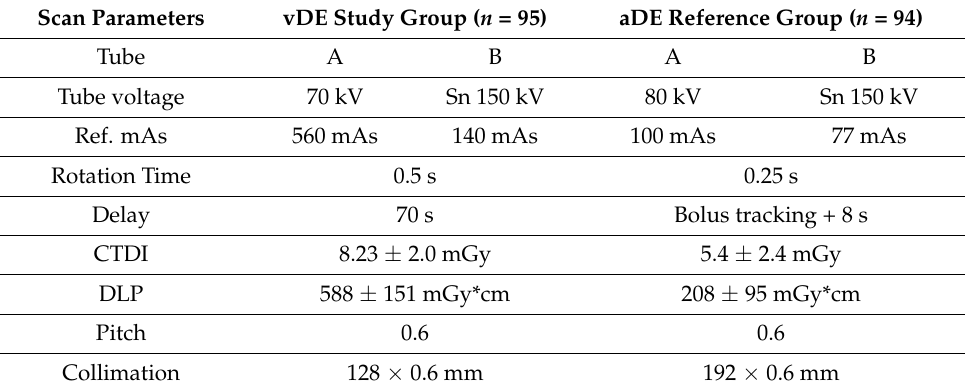
Table 1. Dual-energy protocols for portal–venous thoraco-abdominal CT in the study group (vDE—portal-venous thoraco-abdominal Dual Energy CT) and pulmonary arterial CT of the chest in the reference group (aDE—pulmonary arterial Dual Energy CT).